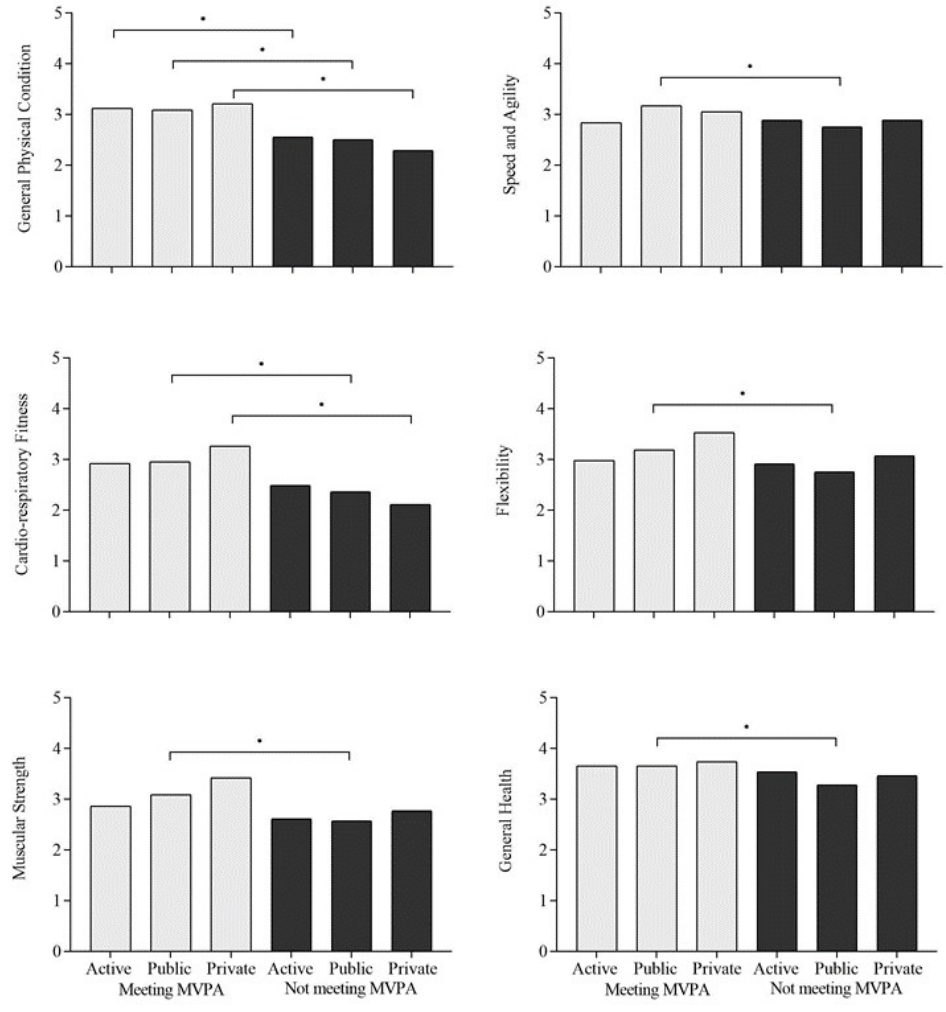
Figure 2. Associations of mode of commuting and meeting MVPA recommendations with fitness in women. Notes: active, public, private = mode of commuting; MVPA = Moderate to Vigorous Physical Activity; Meeting or Not meeting MVPA = MVPA recommendations; * = significant association with p < 0.05 between categorical groups.